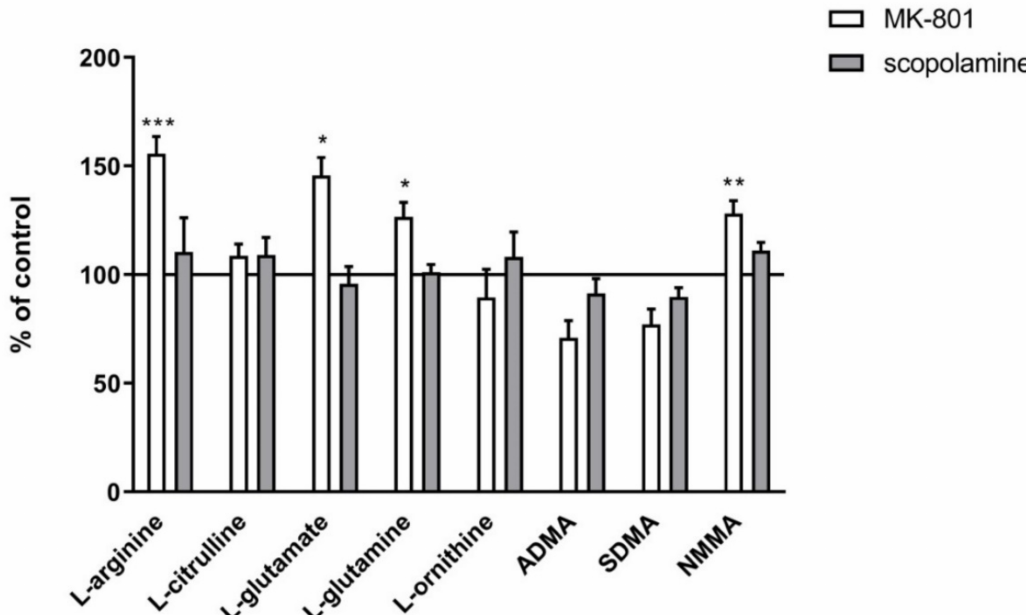
Figure 17. Amino acid and L-arginine derivative levels in plasma after chronic (14 days) administration of MK-801 (0.3 mg/kg) or scopolamine (1 mg/kg). Data are presented as means ± SEM. * p < 0.05; ** p < 0.01; *** p < 0.001 vs.